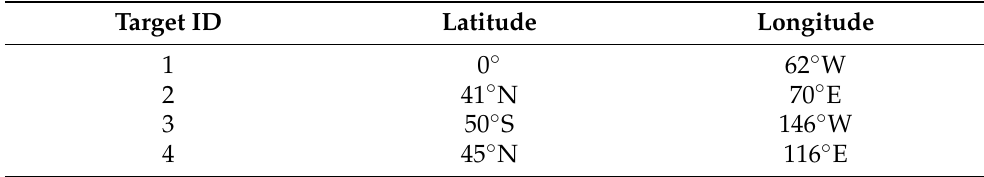
Table 4. Geographical information of ground